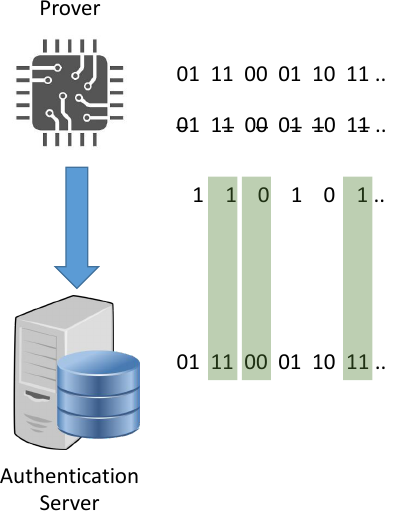
Figure 13. Noise-Bifurcation obfuscation technique.